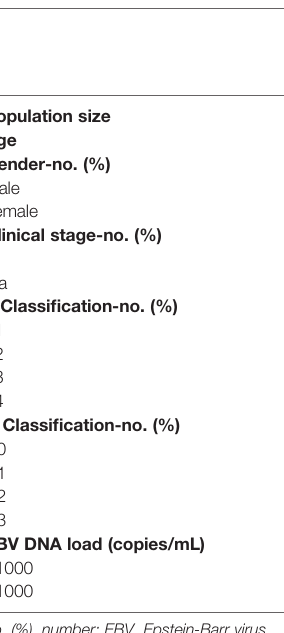
TABLE 1 | Demographics and baseline characteristics of enrolled